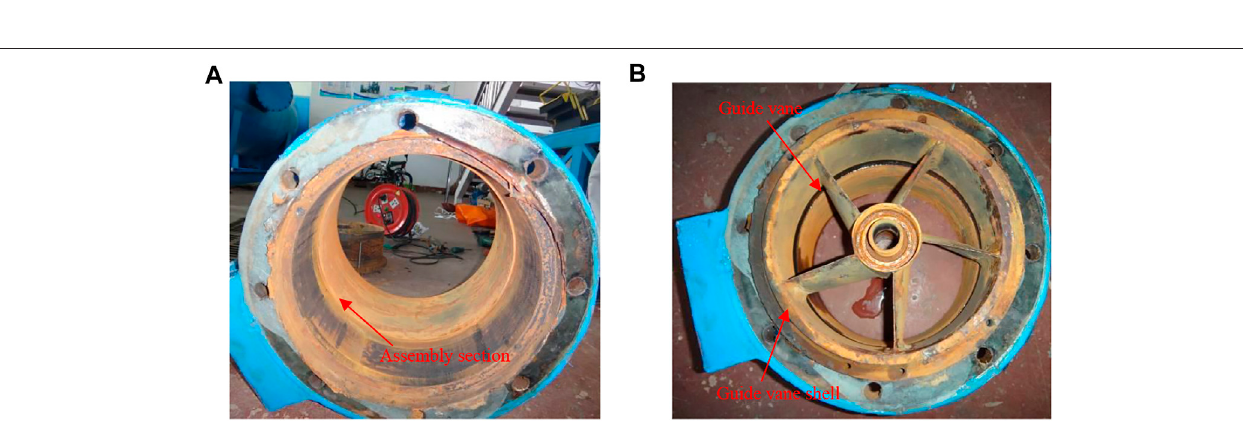
Frontiers in Energy Research |